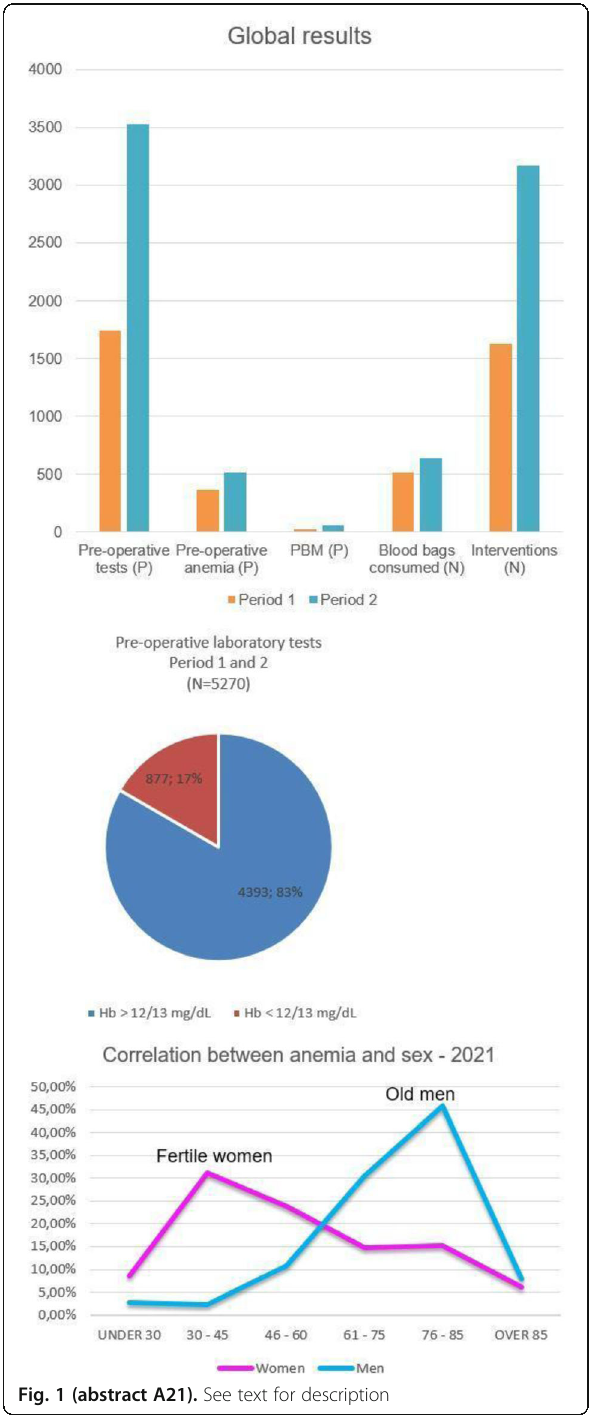
Fig. 1 (abstract A21). See text for